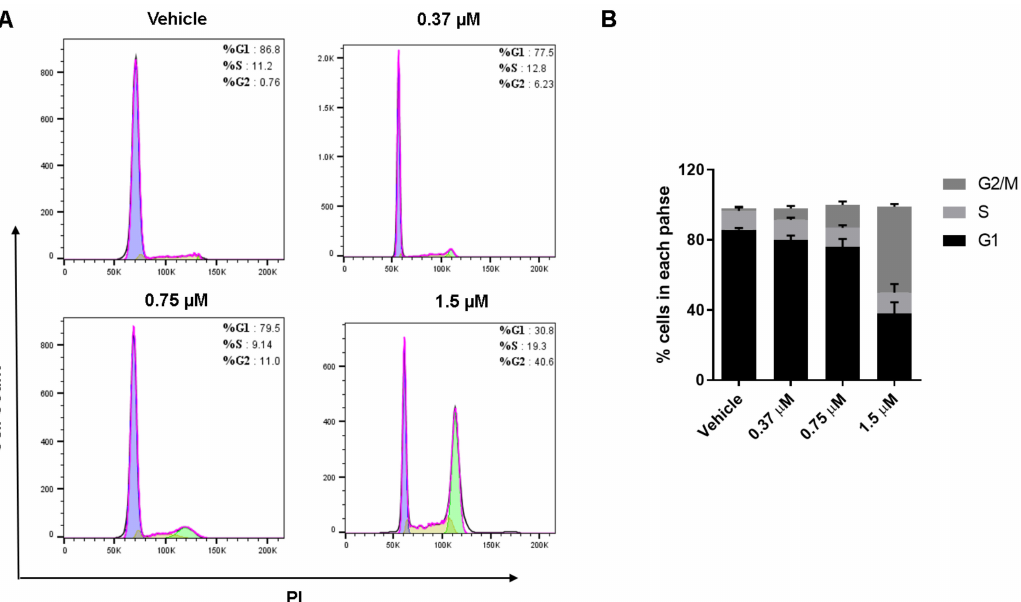
Figure 5. The effect of compound 18 on cell cycle distribution of MGC-803 cells. ( A ) MGC-803 cells were treated with compound 18 at the indicated concentrations for 48 h, which was then analyzed by flow cytometry; ( B ) Column chart of the cell cycle distribution of MGC-803